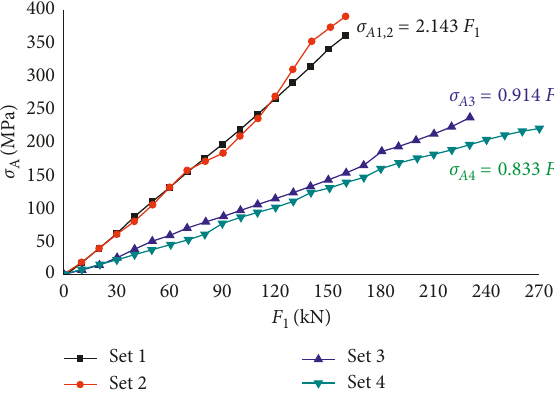
Figure 7: Bending stresses in the top arch. Figure 9. The curve slopes in sets 1, 2, 3, and 4 (i.e., | k 1 |, | k 2 |, | k 3 |, and | k 4 |) are 1.494, 0.515, 0.492, and 0.253, respectively. For sets 2 and 3, the slopes are close to each other, which same strength regardless of one more roof beam in set 3.